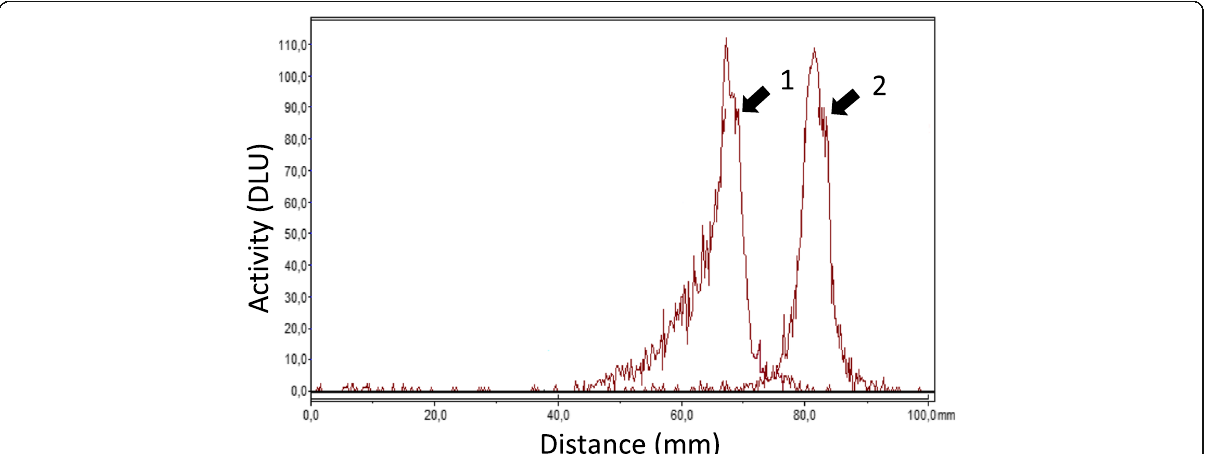
Fig. 2 SDS-PAGE analysis of 111 In-tilmanocept. 1 111 In-tilmanocept sample, which was incubated in murine serum at 37 °C for 90 min. 2 111 In-acetate, which was used as a low molecular weight radioactivity marker on the same